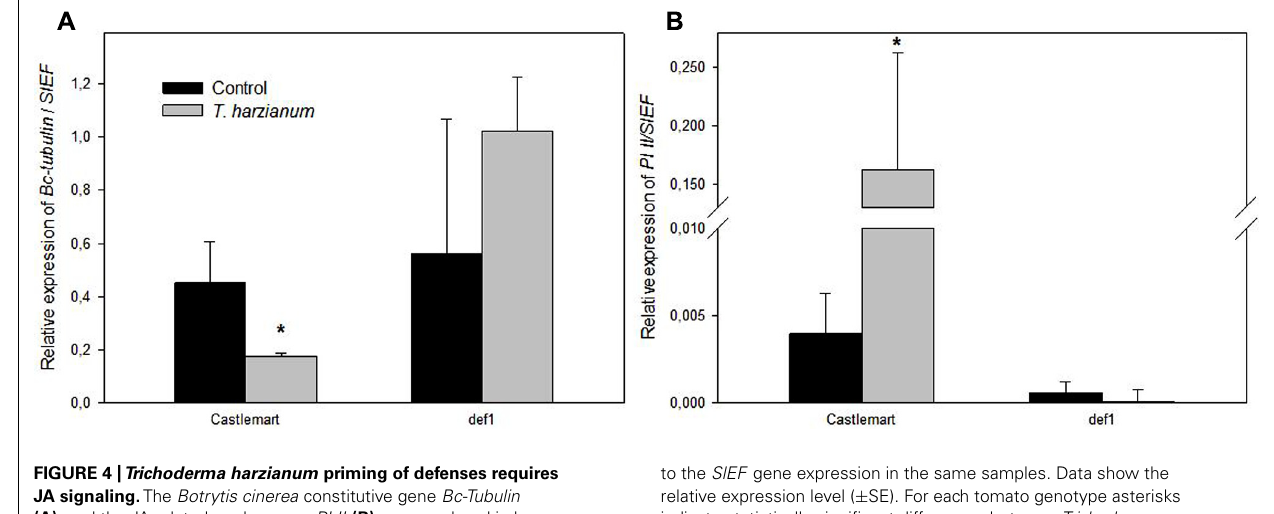
FIGURE 4 | Trichoderma harzianum priming of defenses requires JA signaling. The Botrytis cinerea constitutive gene Bc - Tubulin (A) , and the JA-related marker gene PI II (B) were analyzed in leaves of the wild-type tomato plants cv. Castlemart and the JA-impaired mutant def1 upon 96 h of B. cinerea infection. Results were normalized